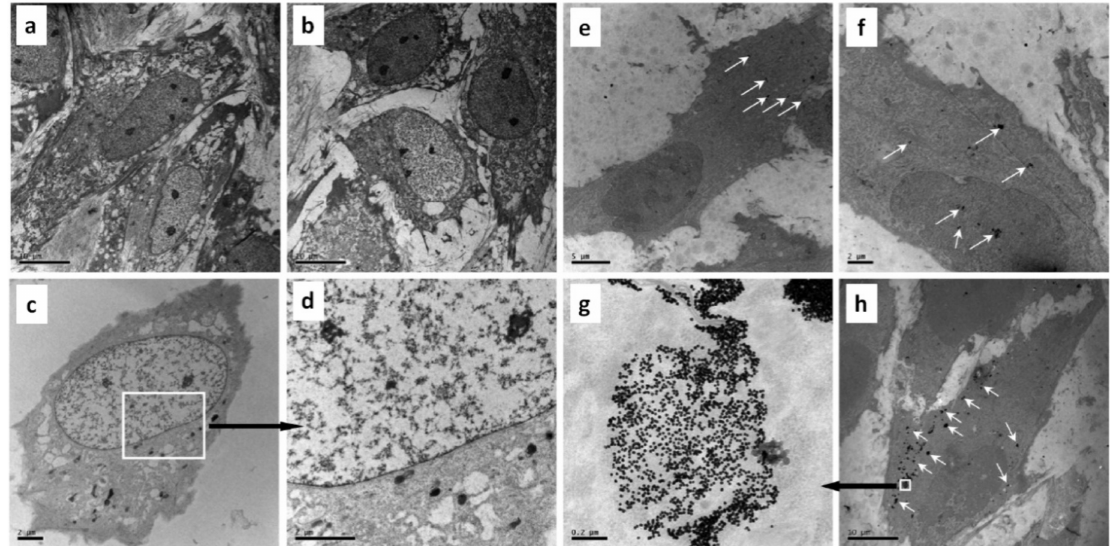
Figure 4. Transmission electron microscope (TEM) images of the internalization of AuNPs. ( a – d ): Cells were treated with OS as a control; ( e – h ): cells were treated with OS and 1.0 nM AuNPs. Arrows indicate AuNPs. The images are representative of three independent experiments. Reproduced from [48], with permission of American Chemical Society 2010. Abbreviation: OS—osteogenetic induction